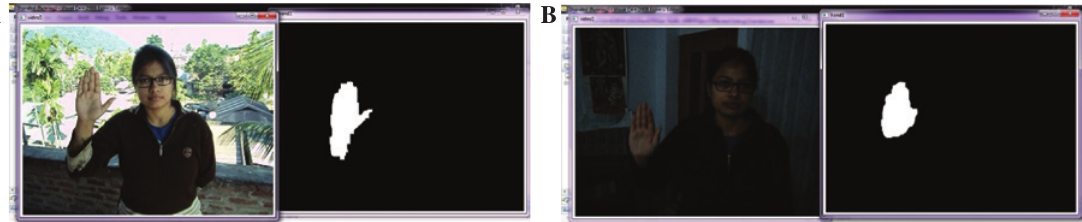
Figure 10: Segmented Output Using the Proposed Model. Under (A) daylight condition and (B) dimlight